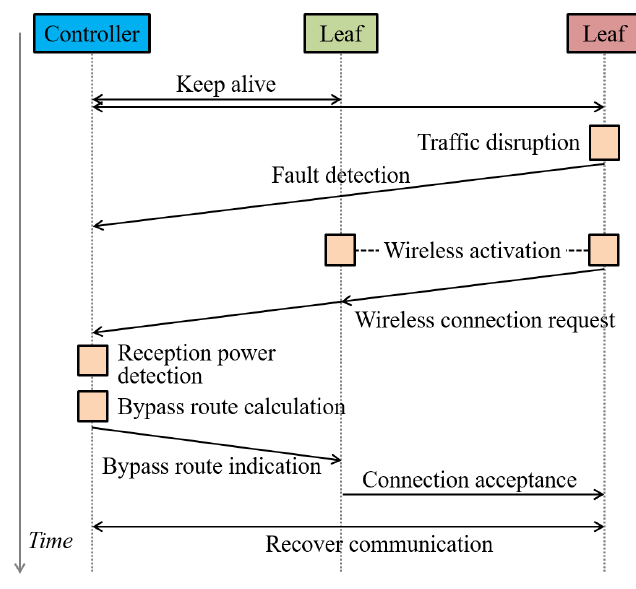
Figure 2. Recovery sequence for the NeCo